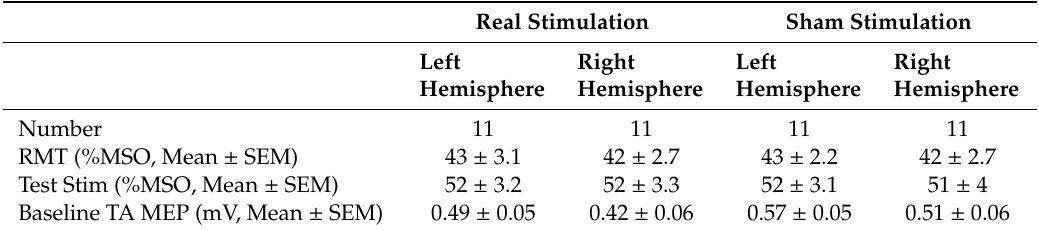
Table 1. Baseline TMS data in all